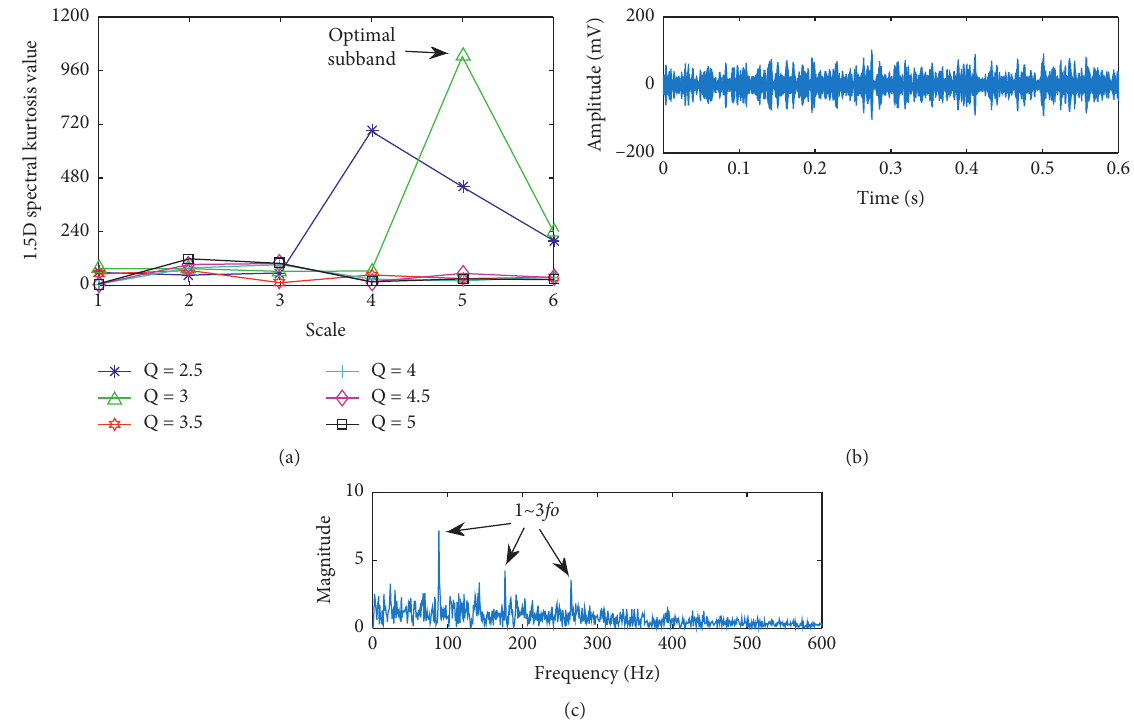
Figure 16: (a) Optimal subband selection process of the 1.5D spectral kurtosis-guided TQWT method, (b) time-domain waveform of the optimal subband, and (c) 1.5D spectrum of